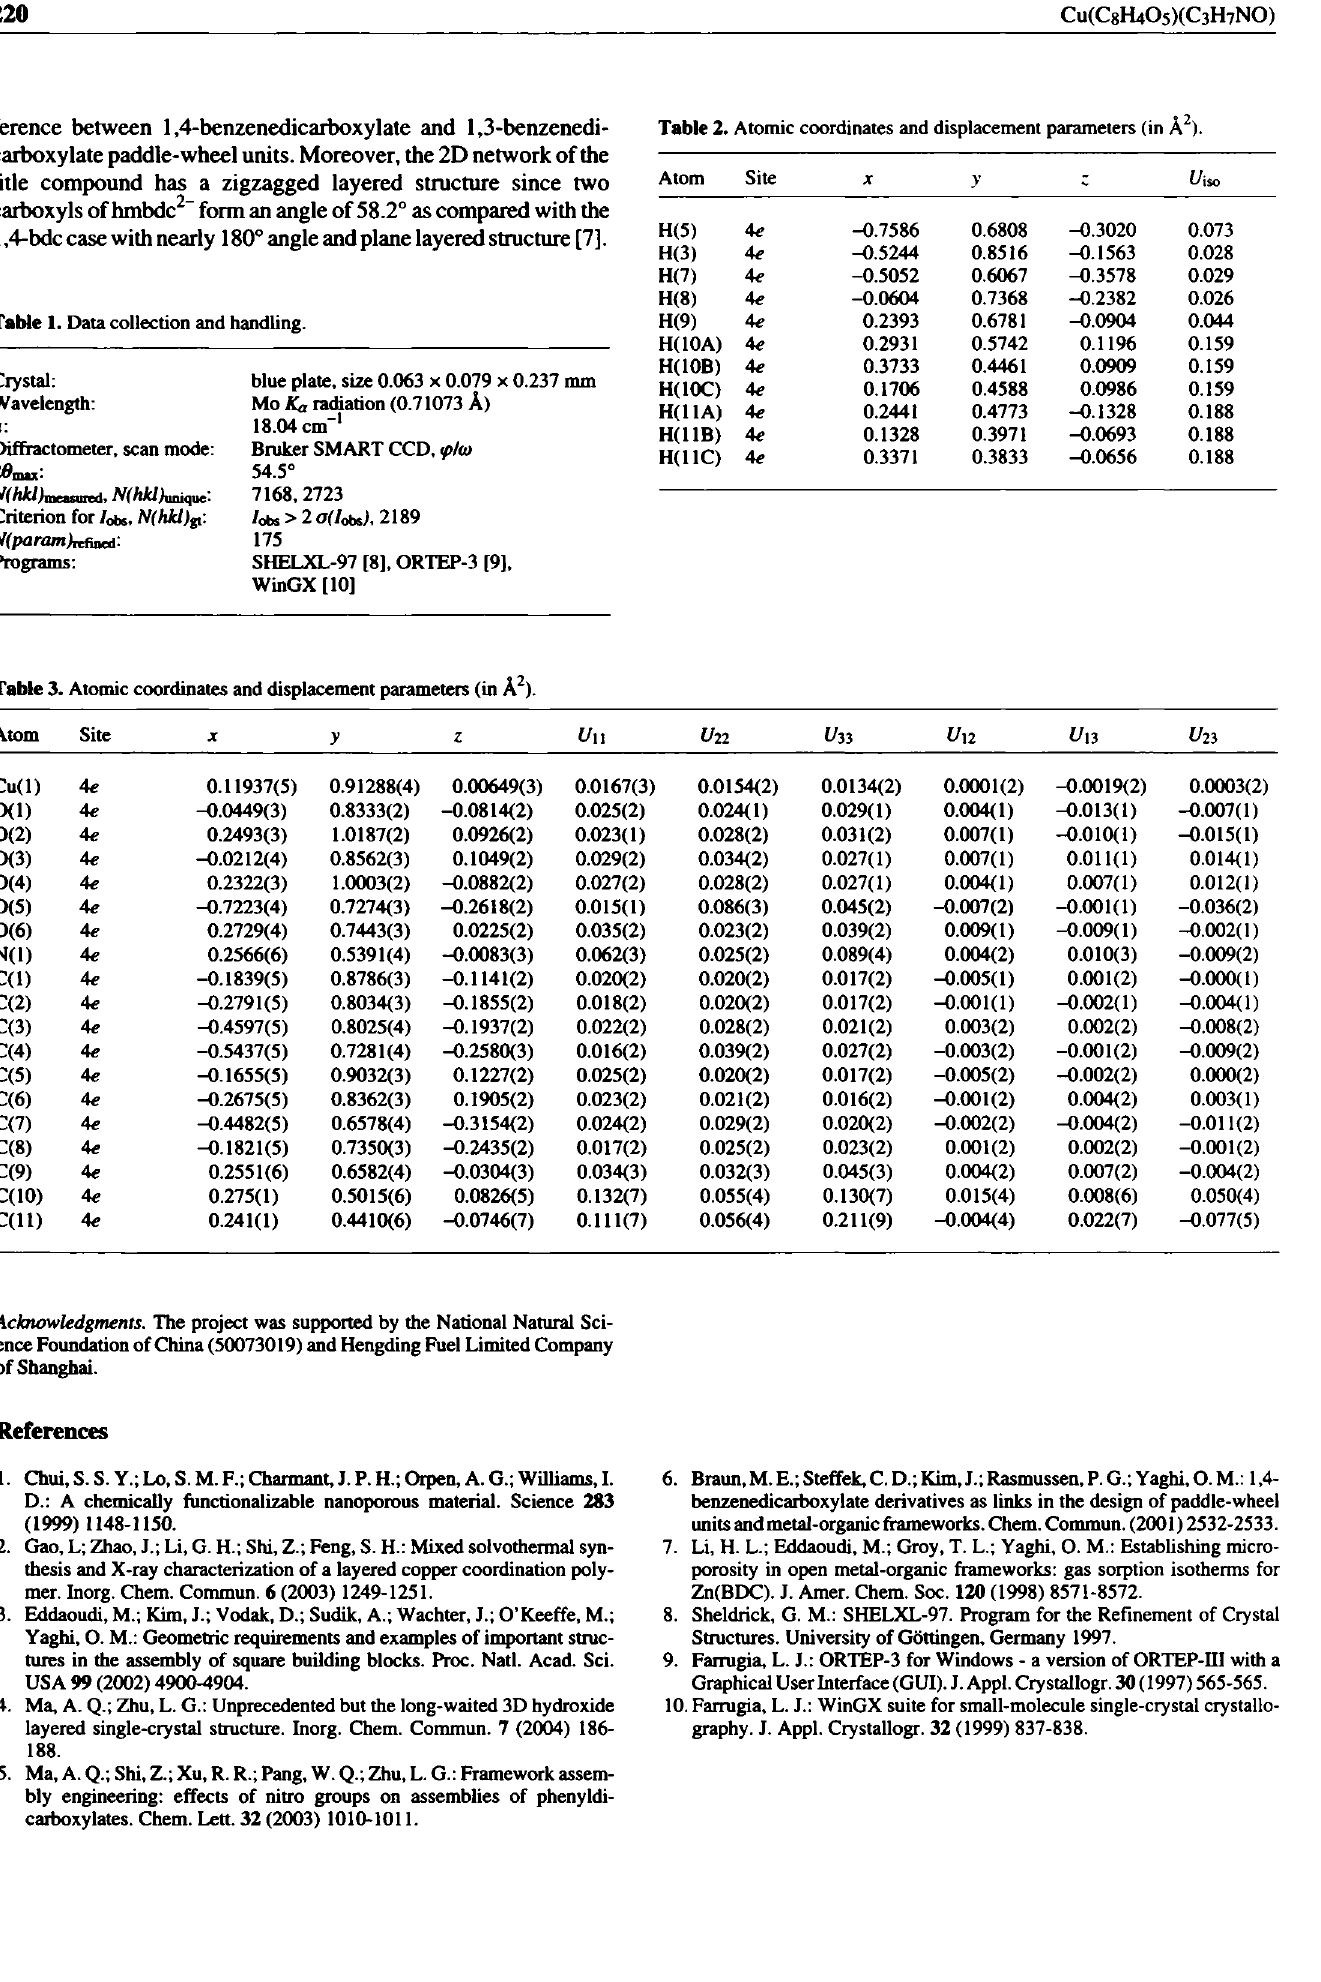
Table I. Data collection and handling.